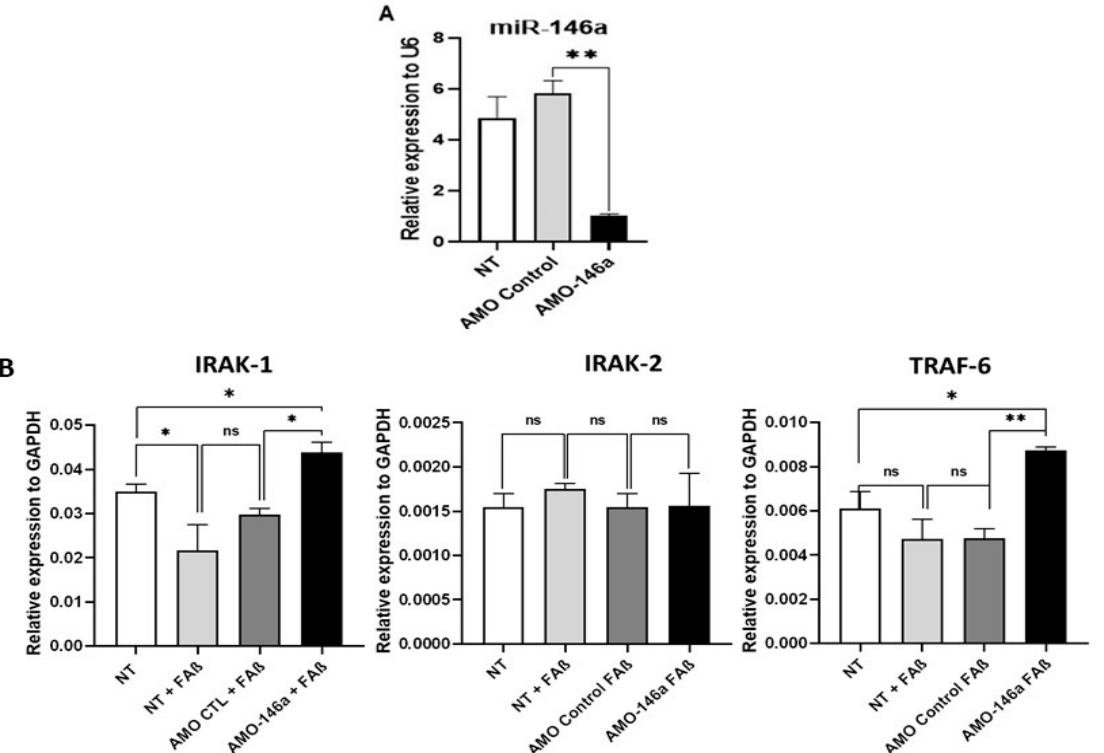
Figure 10. Transfection of miRNA-146a-5p inhibitor in FA β 1–42 -treated astrocyte cells rescues expres- sion of IRAK-1 and TRAF-6 but not IRAK-2. ( A ) qRT-PCR evaluation of performance of anti-miR-146a oligonucleotides (AMO-146a) to down-regulate expression of miRNA-146a-5p in astrocytes. ( B ) qRT-PCR evaluation of impact of AMO-146a transfection on expression of transcriptional targets of miRNA-146a-5p in FA β 1-42 -astrocyte-treated cells. Cells were first transfected with AMO-146a or AMO-CTL (100 nM), then treated with FA β 1-42 peptides solutions (2 µM) before quantification of the relative expression of IRAK1/2 and TRAF-6 transcriptional targets of miRNA-146a-5p. Non-treated astrocytes (NT, no FA β 1-42 treatment) were used as additional control. Data are represented as mean ± SEM of one representative experiment performed twice in triplicate. Statistical comparisons be- tween groups were made using a Student’s t -test. * p ≤ 0.05, ** p ≤ 0.01.